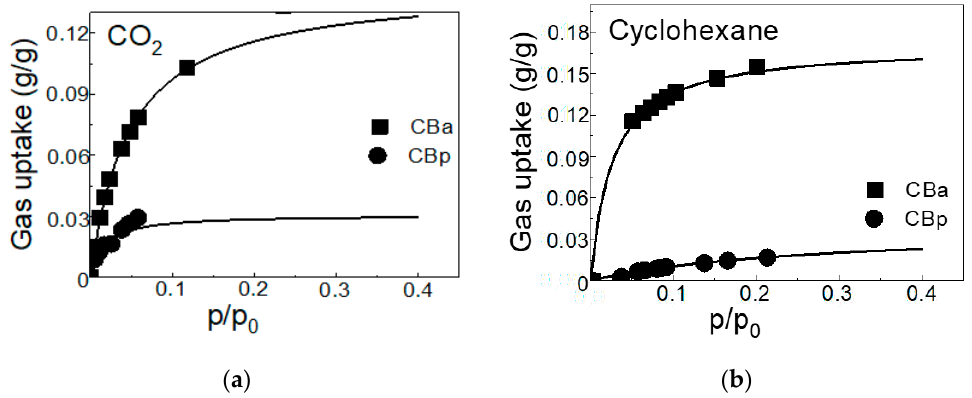
Figure 6. Adsorption and Langmuir isotherms of CO 2 ( a ) for CB p and CBa at 20 °C and cyclohexane ( b ) vapor for CBp and for CBa at 30 °C.